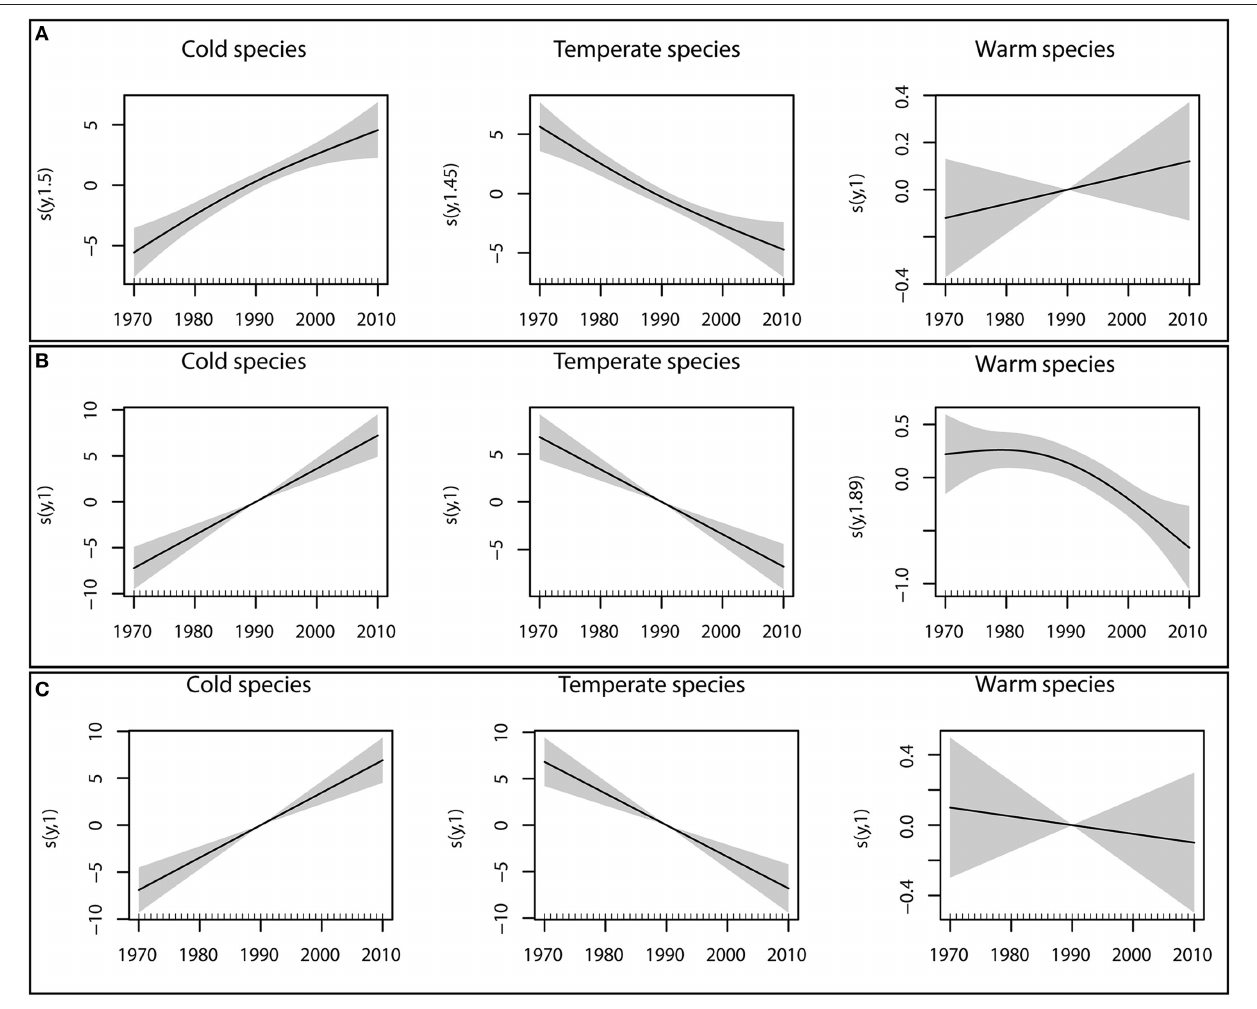
FIGURE 3 | Smooth terms (s) associated with the variable year (y) in the GAM models. (A) the model B.4 (eight FAO-areas), (B) the model B.5 (three macroareas), and (C) the model B.1 (Mediterranean basin). Fitted values are adjusted to average zero and the gray bands indicate 95% pointwise confidence intervals, tick marks show the location of observations along the variable range, the label of the y-axis reports the estimated degrees of freedom (edf) for each model, noted as s(y,